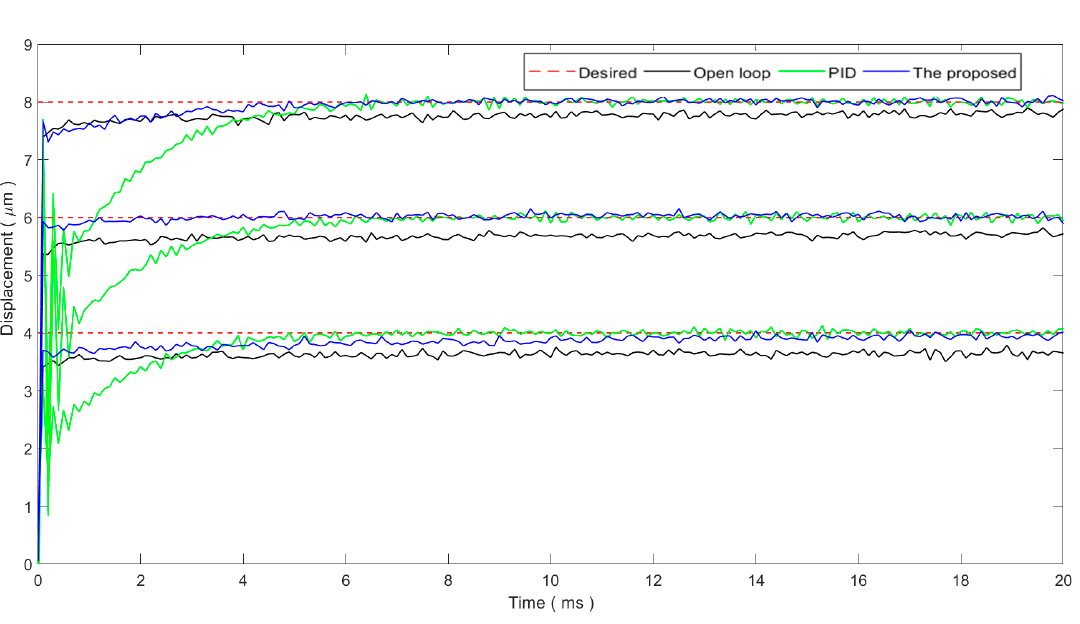
Figure 4. Step response performance.